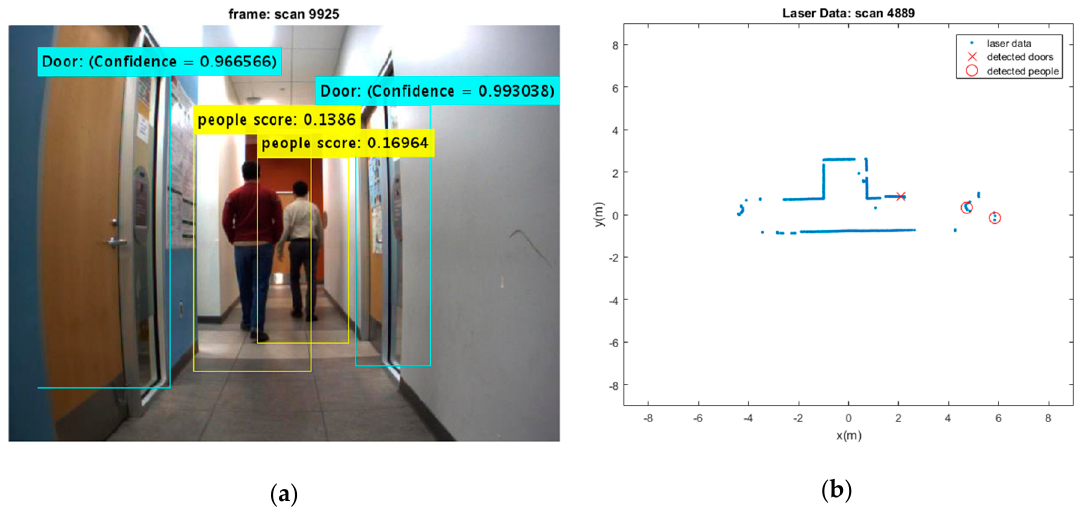
Figure 6. ( a ) Three detected moving people; ( b ) Their extracted depth from laser sensor.